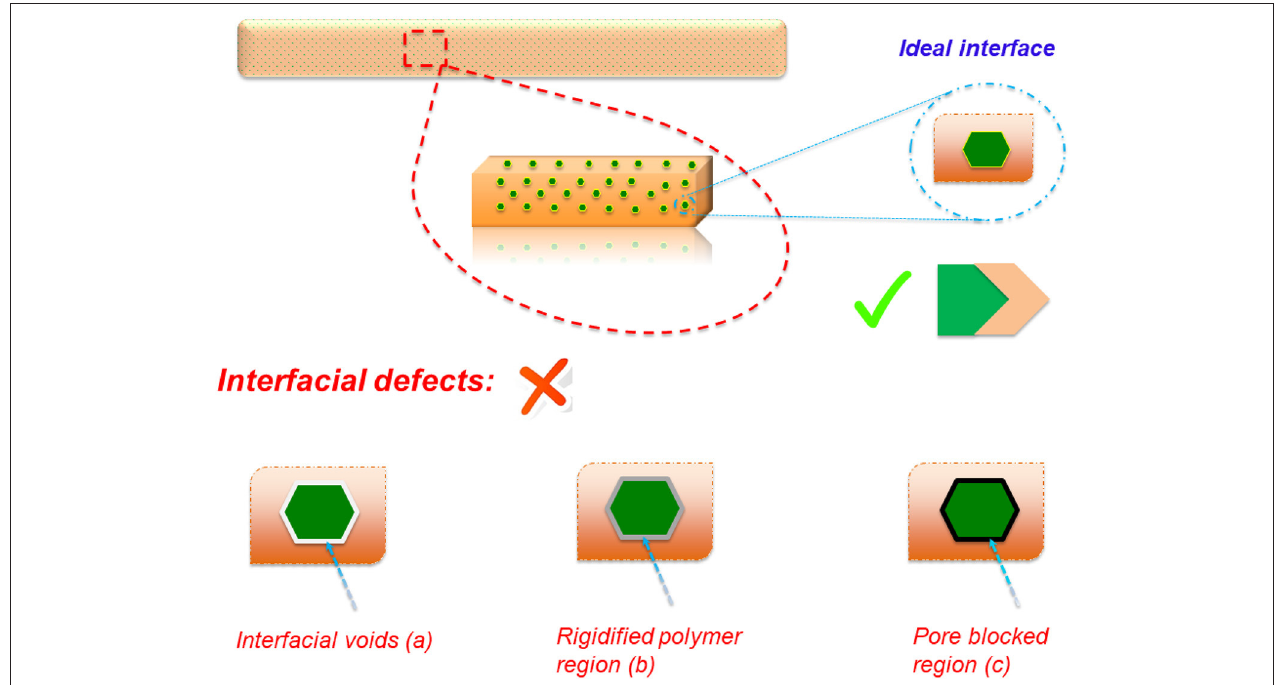
FIGURE 3 | General depiction of an ideal interface of a mixed matrix membrane and its non-ideal defects.